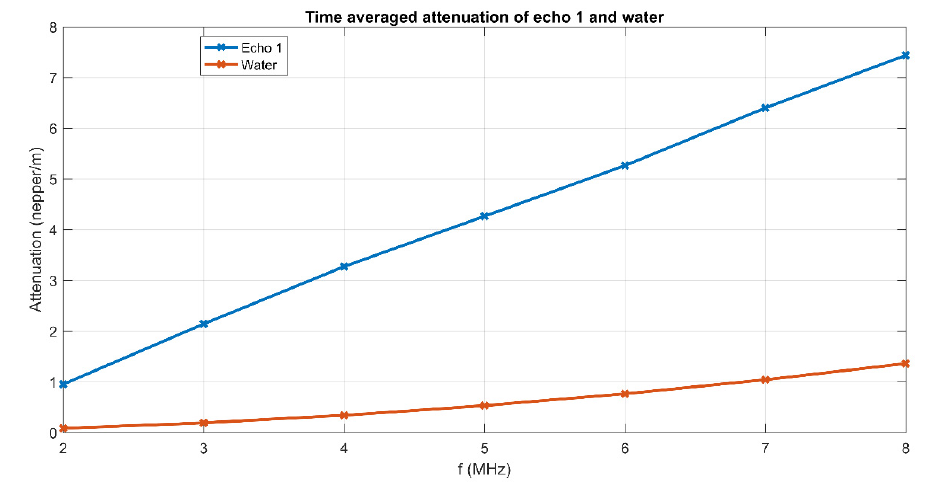
Figure 6. Attenuation vs. time for the spectral components of echo 1.